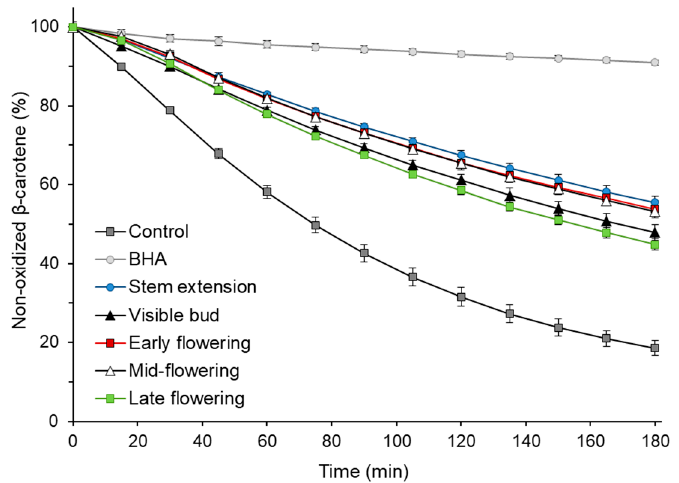
Figure 2. Antioxidant activity of the sunflower plant extracts at various growth stages in the β -carotene–linoleic acid emulsion; BHA, butylhydroxyanisole.